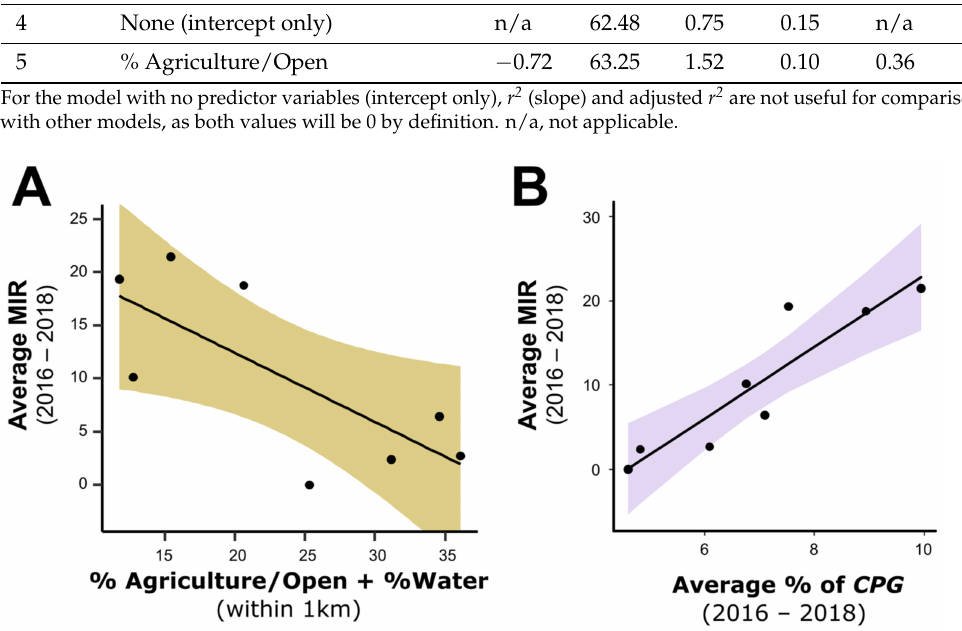
Figure 4. Predictors of mosquito MIRs. Correlations of mosquito minimum infection rate (MIR) with landscape or mosquito variables were examined among sites in central Iowa, USA. ( A ) The landscape variable that best predicted MIR was the combination of % agriculture/open plus % water (, ∆ AICc = 0, adj. r 2 = 0.47, F 1,6 = 7.27, p = 0.04). This variable correlated highly ( r = − 0.97) with the metric we predicted would best describe suburban habitats at high risk for WNV transmission (% tree plus % built). However, models including these variables showed only marginally better support than the null, intercept-only model ( ∆ AICc = 0.75). ( B ) Among metrics of mosquito and avian communities, the percentage of mosquitoes in the Culex pipiens group during the late season was the best predictor of MIR across sites ( ∆ AICc = 0, adj. r 2 = 0.81, F 1,6 = 31.76, p = 0.001). Shading depicts ± 1 SE around model predictions. Table 2. Top five models predicting mosquito minimum infection rate (MIR) based on metrics of mosquito and bird